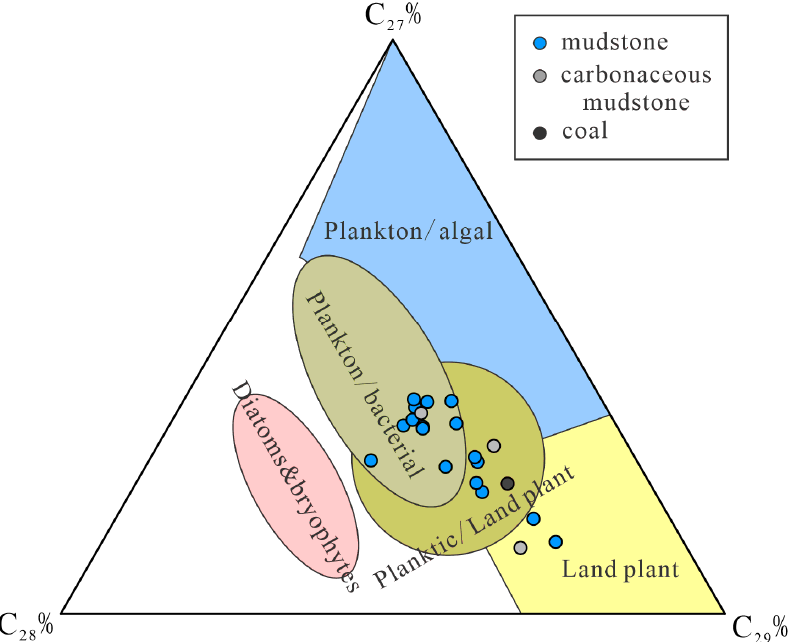
Figure 10. Ternary diagram of regular steranes (C 27 , C 28 and C 29 ) showing the relationship between sterane compositions and organic matter input (modified after Huang and Meinschein, 1979 [37]).